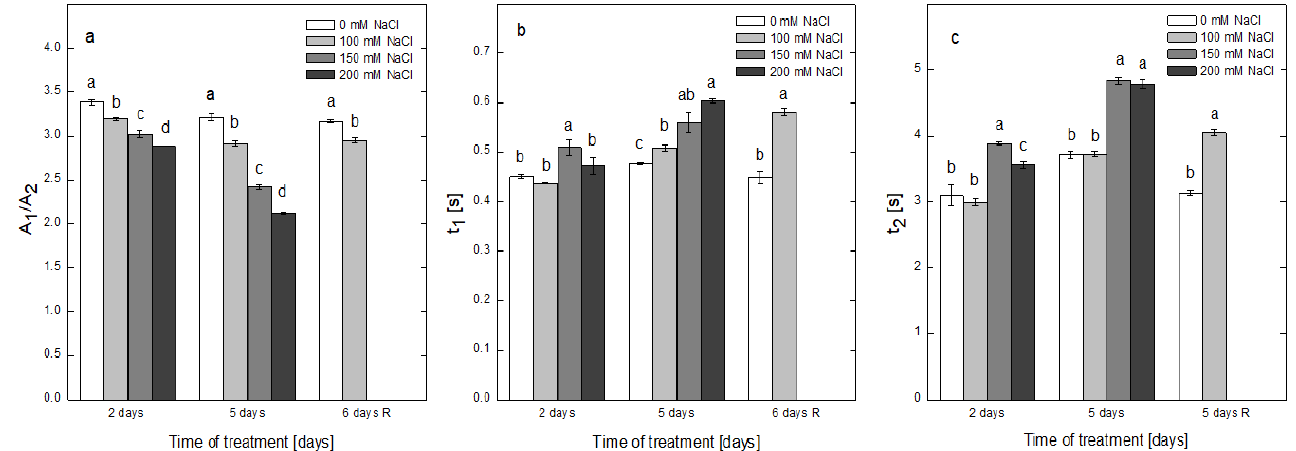
Figure 7. Effect of salt stress on the ratio between the amplitudes of the “fast” (A 1 ) and “slow” (A 2 ) components of the decay kinetics of initial oxygen burst under continuous illumination related to the PSII α and PSII β centers ( a ) and respective time constants of (t 1 ) ( b ) and (t 2 ) ( c ), calculated after fitting the decay kinetics with two exponential components in the thylakoid membranes from the non-treated plants (0 mM NaCl) and plants treated with different concentrations of NaCl for 2 and 5 days and after recovery (6 days R). Calculations were performed through the analysis of second-order exponential decay kinetics. Mean values ± SE were calculated based on three independent experiments with two parallel samples for every time point ( n = 6). Different letters indicate significant differences between values for the control plants (0 mM NaCl) and plants treated with increased concentrations of NaCl at p < 0.05 for the respective period of the experimental setup (2 and 5 days of treatment and the recovery